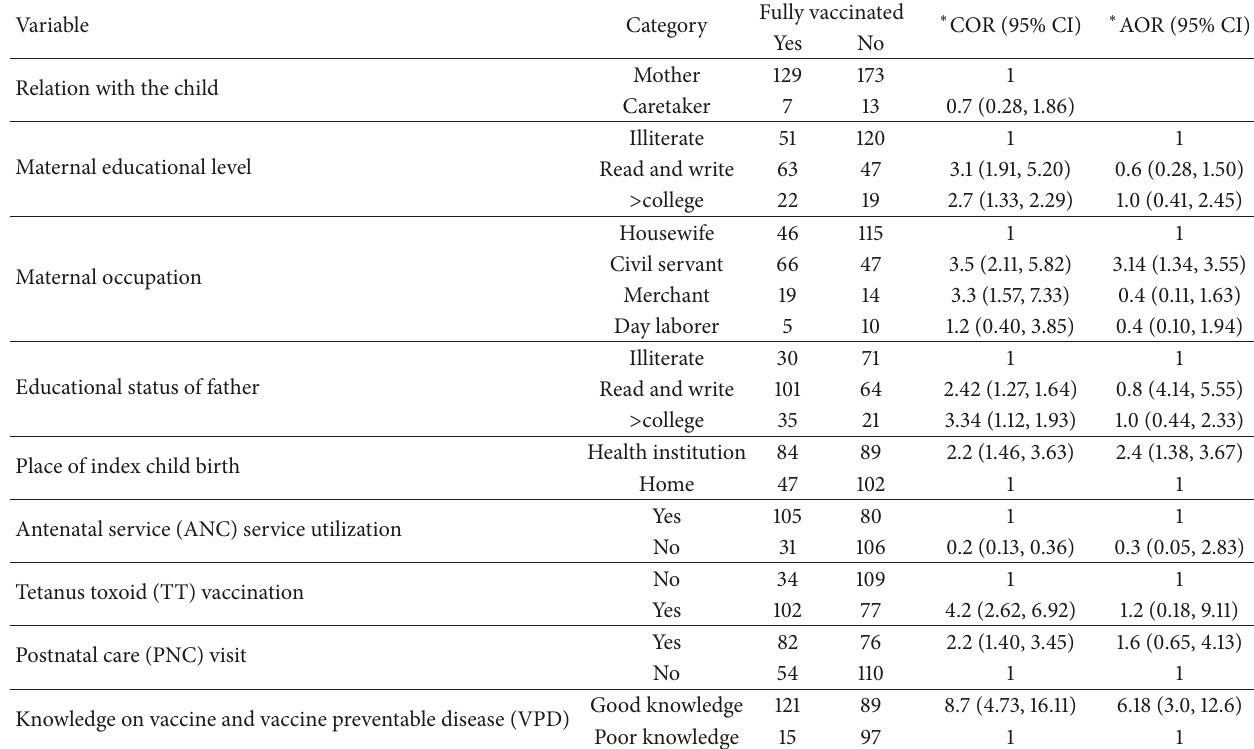
Table 5: Completion of immunization by sociodemographic characteristics of the mother at Mizan Aman town, Bench Maji zone, Southwest Ethiopia,